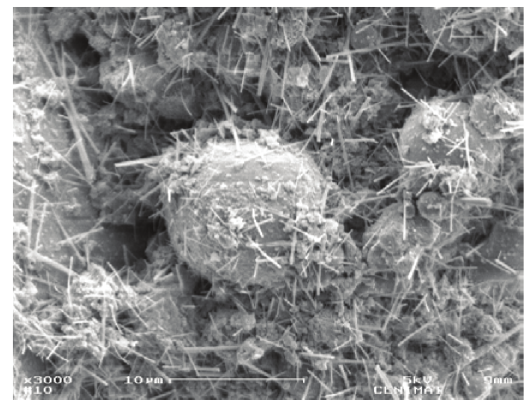
Fig. 8(b). Effect of pozzolans and SP on air content of fresh grouts